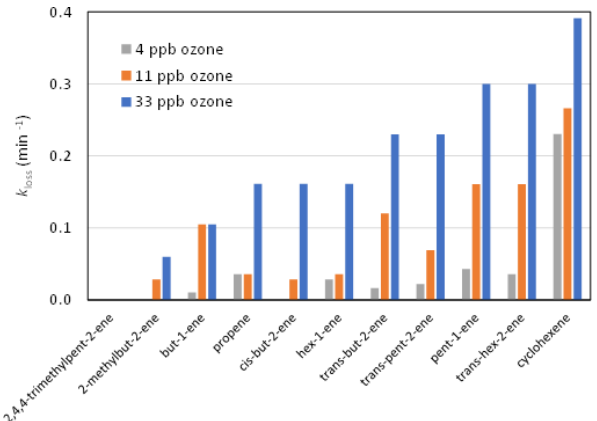
Figure 1. Average E. coli loss rate ( k loss ) during the ozonolysis of selected alkenes in the experiments of Dark and Nash (1970), illustrating the variation of loss efficiency with alkene structure and ozone mixing